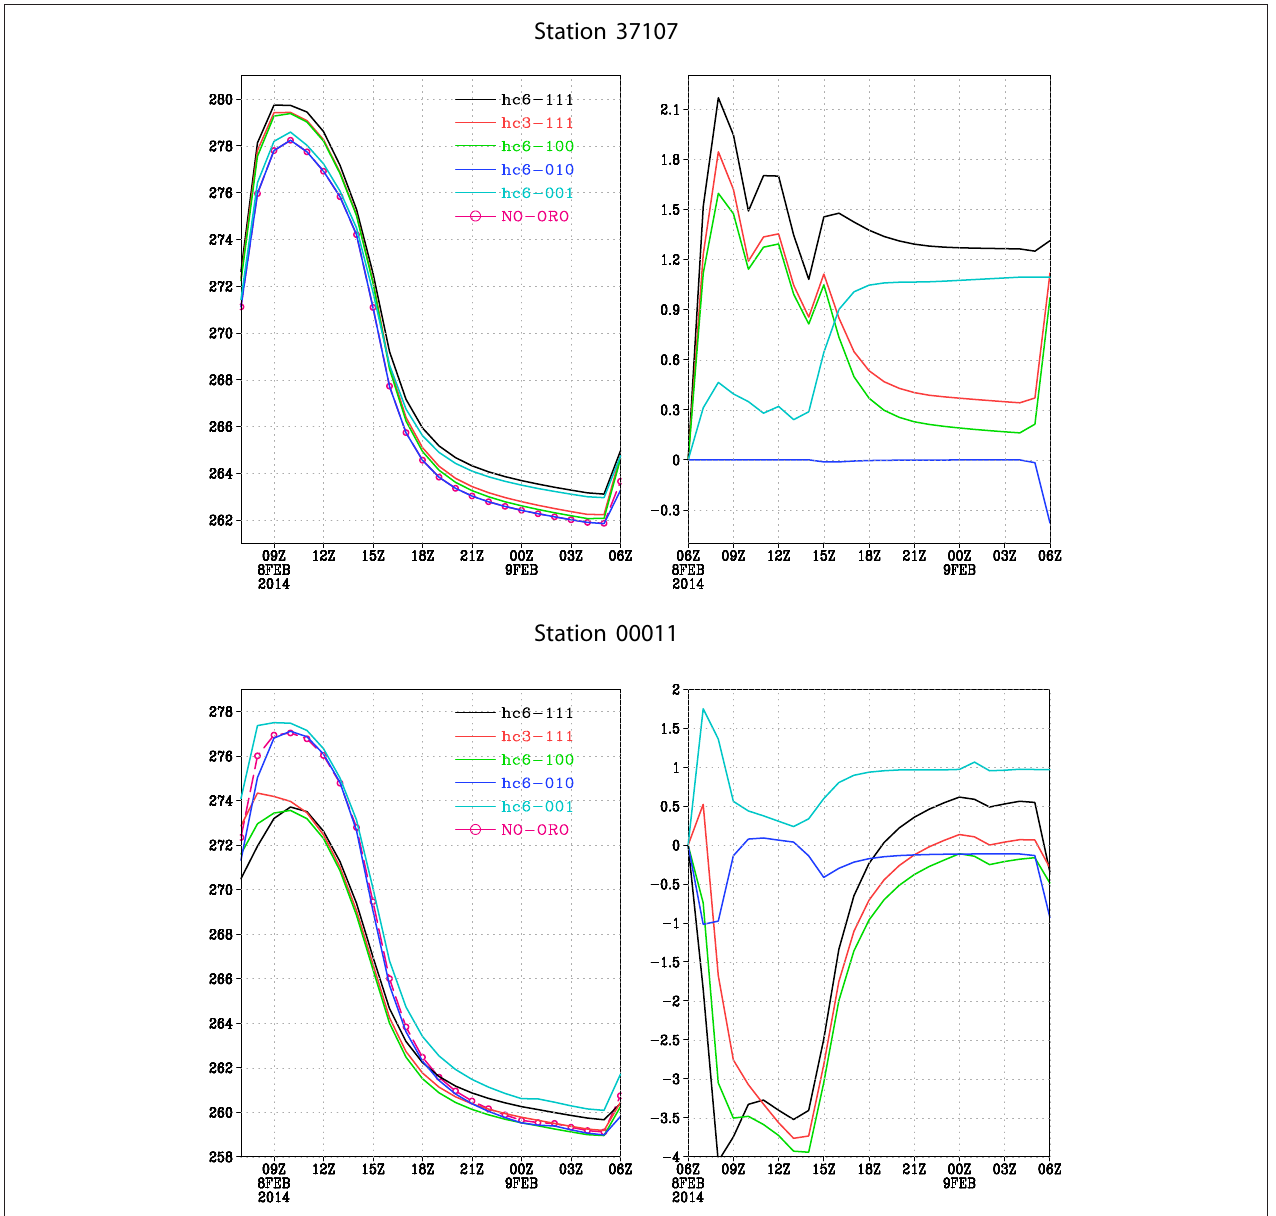
FIGURE 12 | Surface temperature T s (K, y-axis) as a function of time (x-axis) for the stations 37107 (upper panel) and 00011 (lower panel) from MUSC experiments initiated at 06 UTC the 8th of February 2014. Values on the left, difference from the reference (no ororad) on the right. Experiment name is given in the legend as experiment-ororad: hc6, ororad variables from harcau6; hc3, ororad variables from harcau3; 000, no ororad; 111, all ororad; 100, slope effect only; 010, shadow effect only; 001, sky view effect